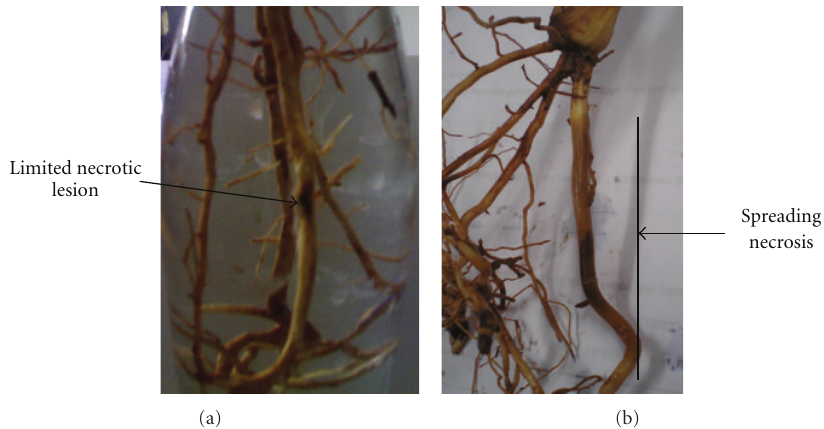
Figure 1: Without SA treatments, diseased control plants showed progressing wet necrosis of the roots (b). In contrast, after SA treatment, plants developed limited necrotic lesions